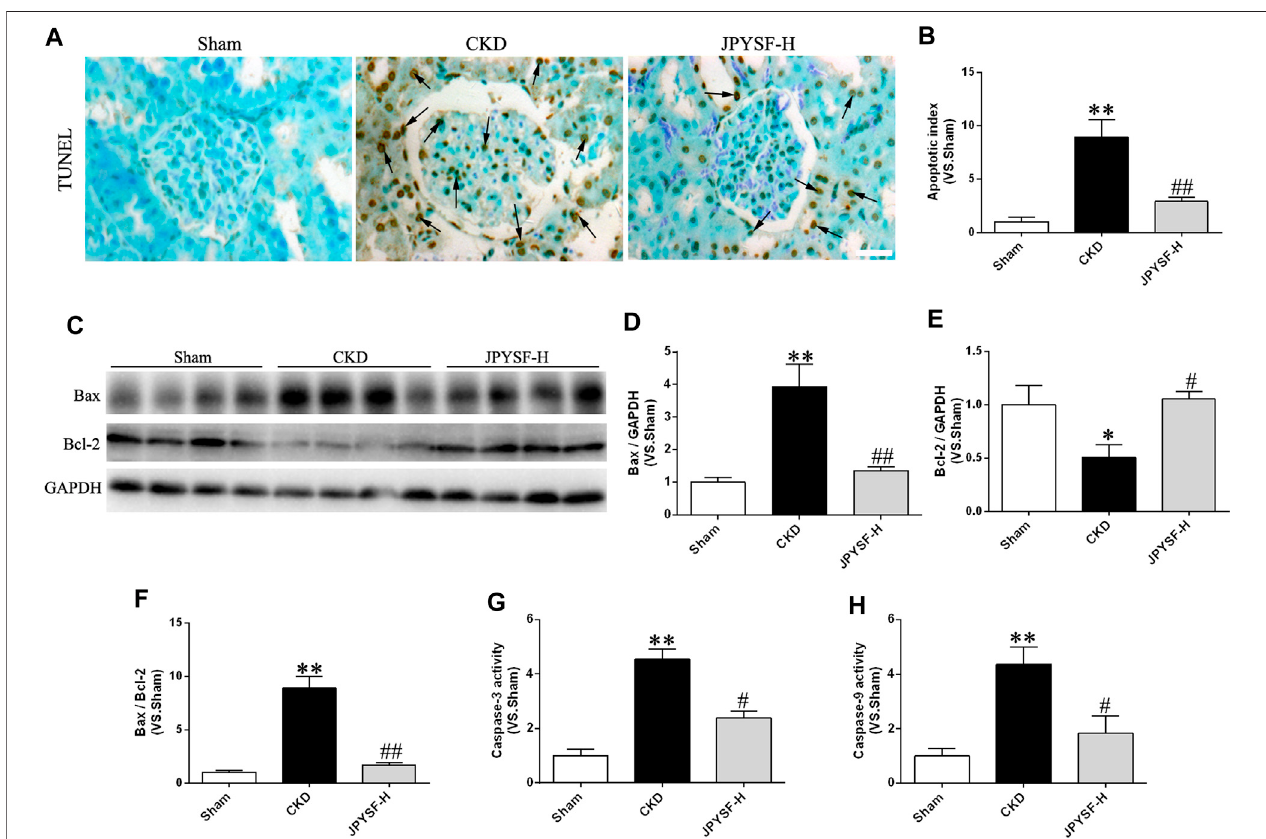
FIGURE 5 | JPYS formula prevents renal cell apoptosis in CKD rats. (A) Terminal dUTP nick end labeling (TUNEL) staining in the kidney ( × 400, scale bar (cid:2) 50 μ m). TUNEL-positivenucleiareindicatedbyarrows. (B) ThenumberofTUNEL-positivecellsisexpressedasthepercentageoftotalcells. (C) Representativewesternblotsfor Bax,Bcl-2,andGAPDHproteinexpressioninkidneytissue. (D) QuantitativeanalysisofBax/GAPDH. (E) QuantitativeanalysisofBcl-2/GAPDH. (F) Quantitativeanalysis ofBax/Bcl-2.Theactivityofcaspase-3 (G) andcaspase-9 (H) .Alldataareexpressedasmeans ± SEM.* p < 0.05,** p < 0.01vs.theshamgroup;# p < 0.05,## p < 0.05 vs. CKD